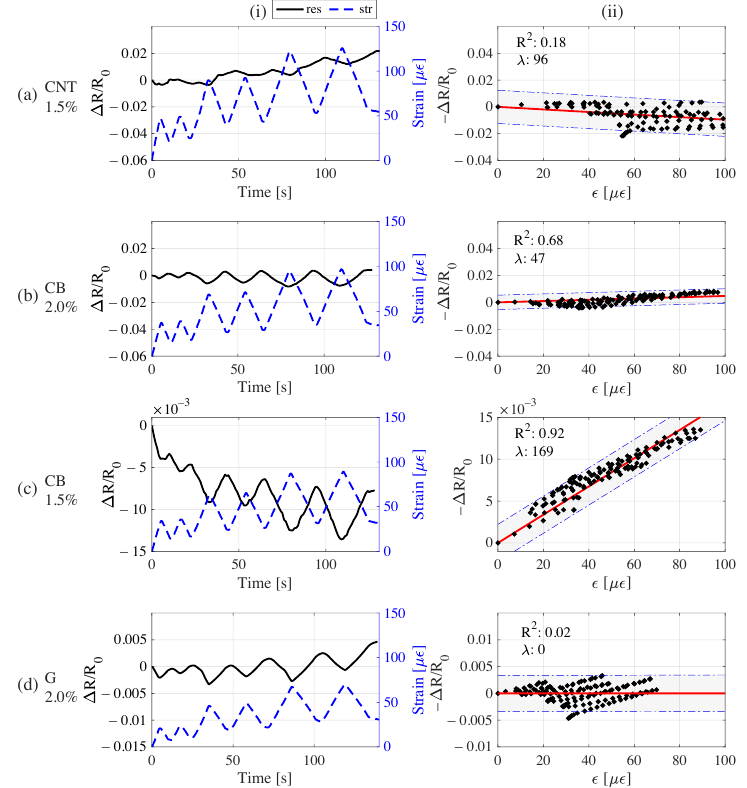
Figure 9. Strain and fractional variation of resistance time histories ( i ) and linear fit models of sensing ( ii ) of the samples with 1.5% CNTs ( a ); 2.0% CB ( b ); 1.5% CB ( c ); and 2.0% G ( d